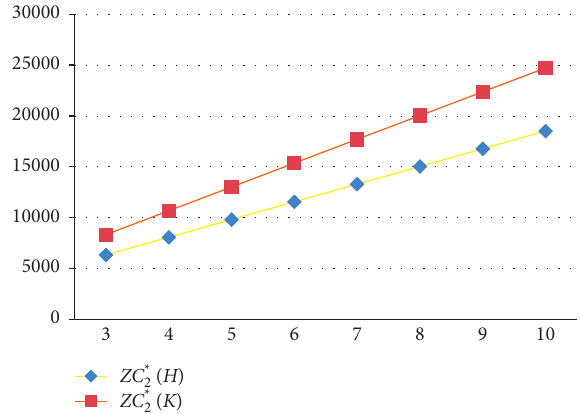
Figure 6: Comparison of ZC ∗ dimensions 3 ≤ n ≤ 10.